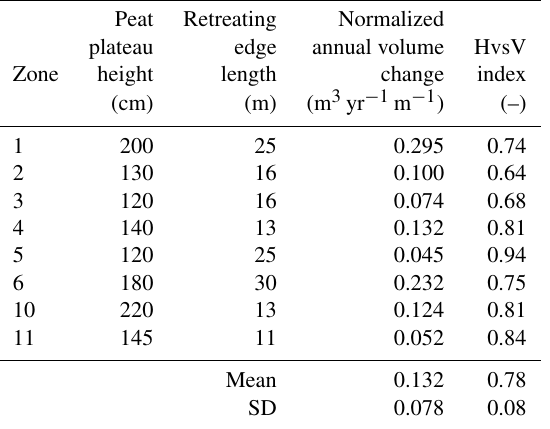
Table 1. Field observations at the eight edge transect areas pre- sented in Fig. 2. Elevation changes and surface measurements are derived from the digital elevation models. The normalized an- nual volume changes are obtained by dividing the annual volume changes by the length of the retreating edge in the zone. The HvsV shape index (Fig. 4) was calculated according to Eq. (1). See Sect. 3.2 for more